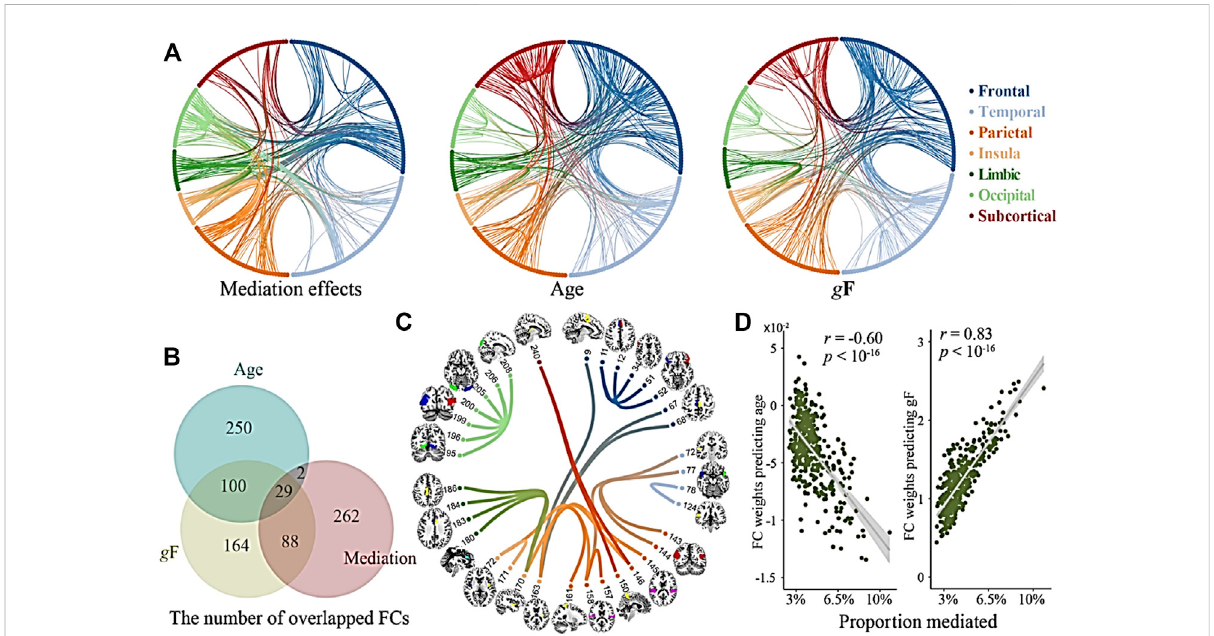
FIGURE 1 Coupling of GMV and gFCD alterations. (A) The mediations effects of GMV and gFCD when age and global structural connection (gF) are regressedout. (B) ThenumbersofoverlappedGMVandgFCDconnections(age,mediationeffects,andgFareregressout). (C) OverlappedGMV and gFCD are associated with cognitive de fi cits. (D) Proportion mediated of age and global structural connections (gF) in the correlations of total functional connectivity